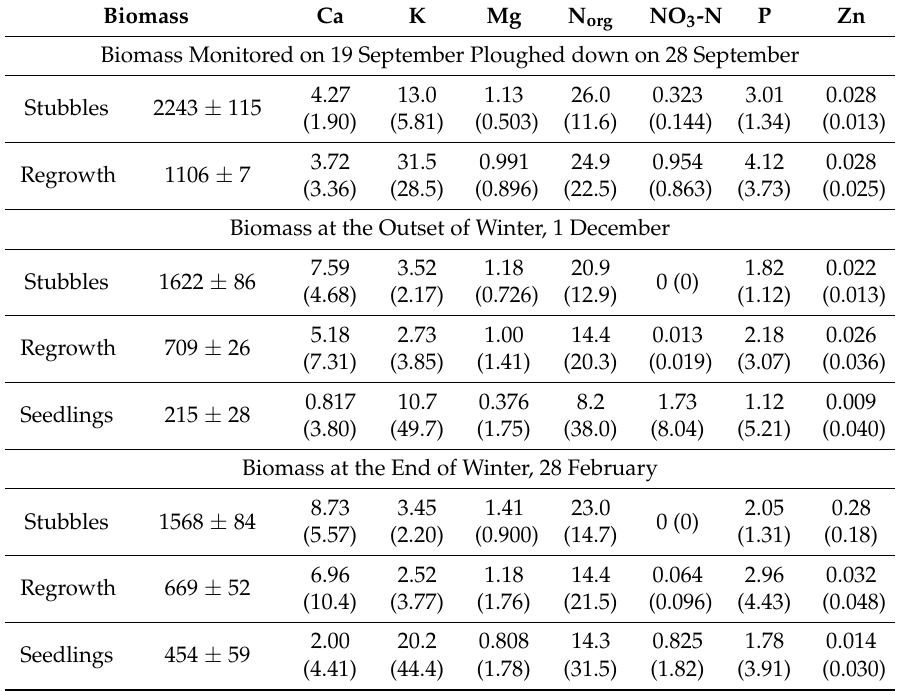
Table 4. Rotation wheat-wheat: Total biomass and minerals (kg ha − 1 DW) of rooted 16-cm stubbles (800 m − 2 ), the regrowth of wheat emerging from spilt grains (both ploughed down on 28 September), and the consecutive wheat crop cv. Bussard sown on 4 October. ( )—concentrations given in kg Mg − 1 DW.